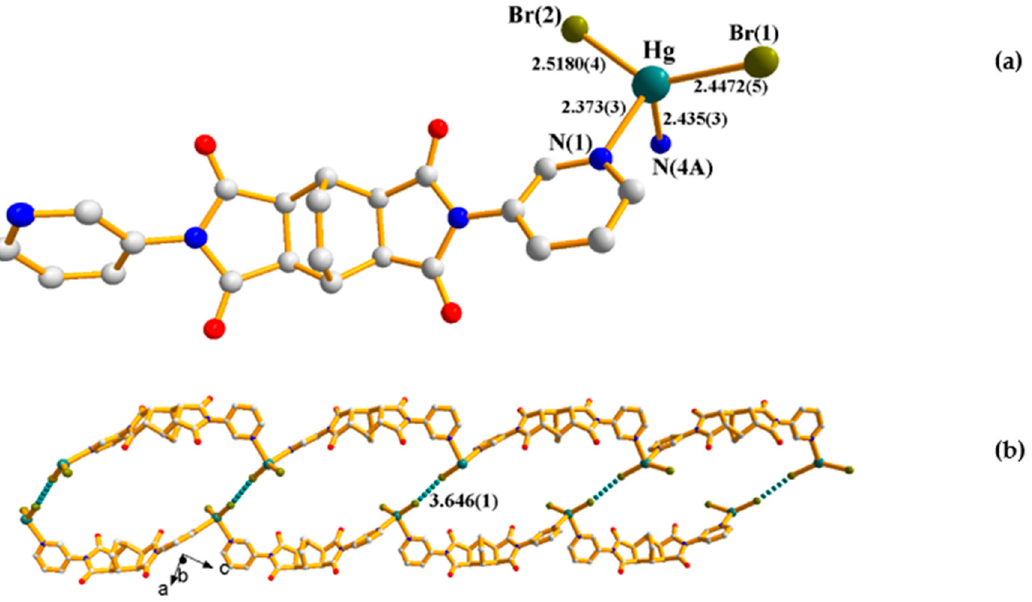
Figure 3. ( a ) Coordination environment about the Hg(II) ion in 2 . Symmetry transformations used to generate equivalent atoms: (A) x − 1, y, z + 1. ( b ) A drawing showing the 1D looped supramolecular chain.